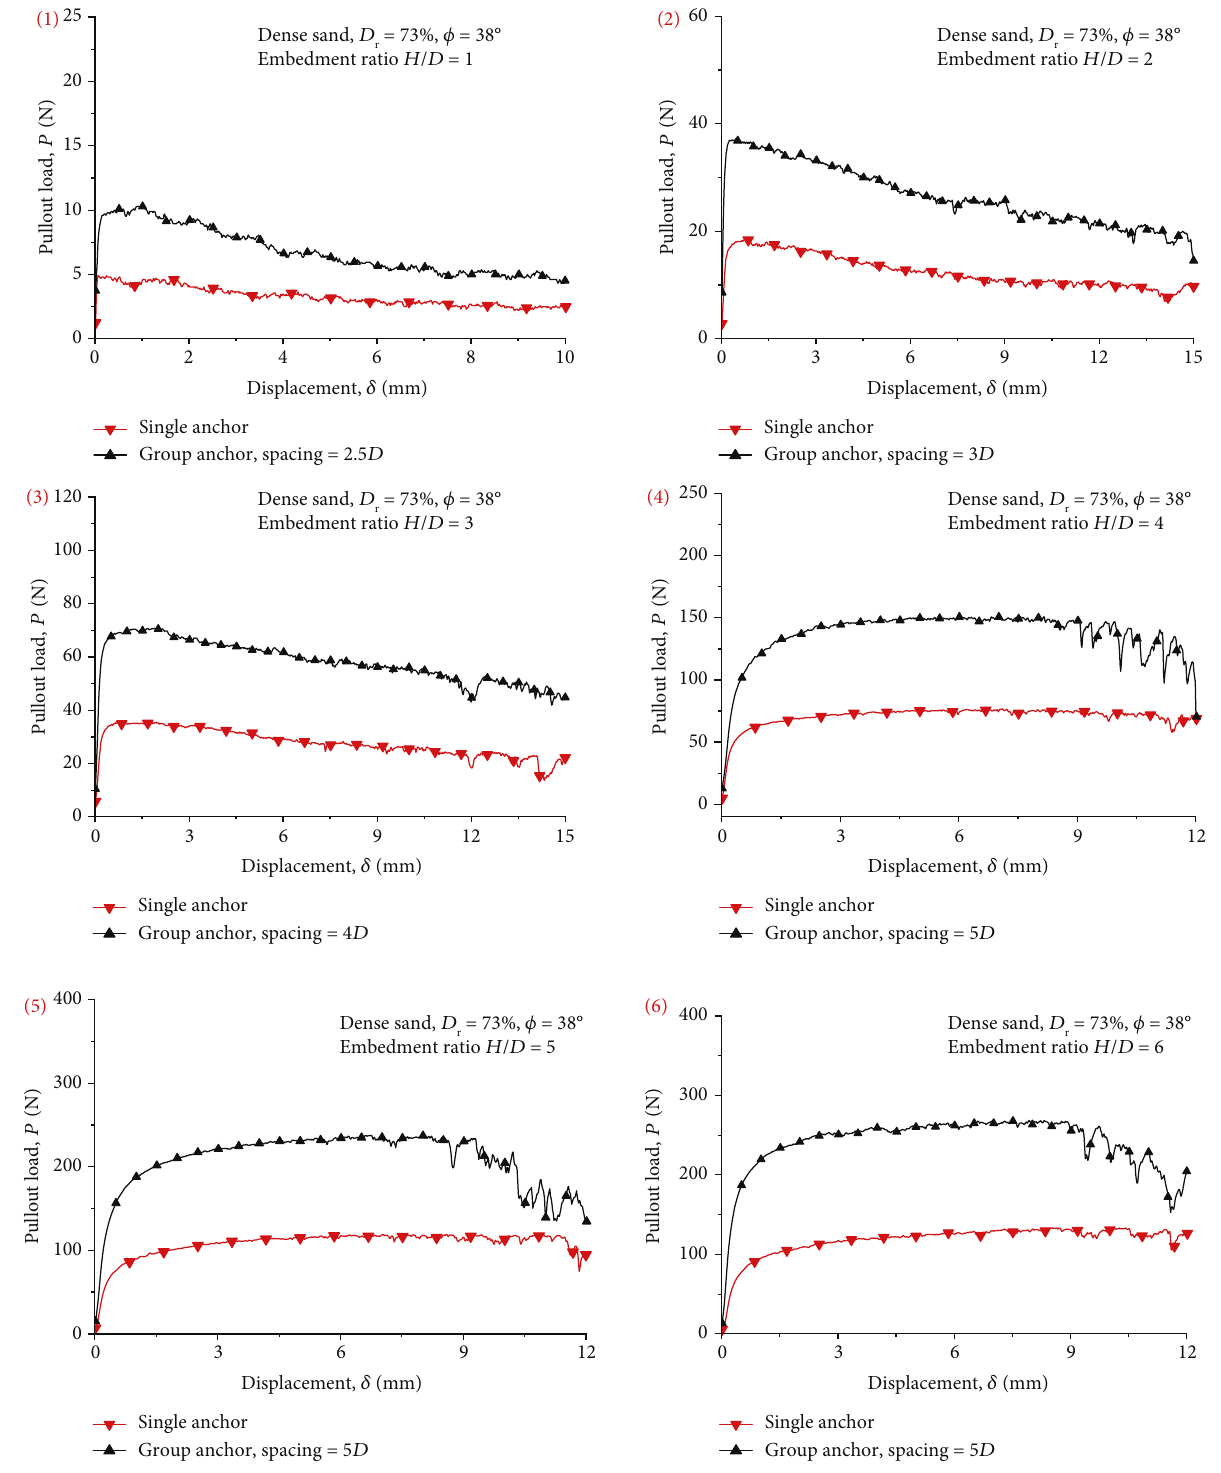
Figure 9: The load-displacement relationships of the experimental results at critical